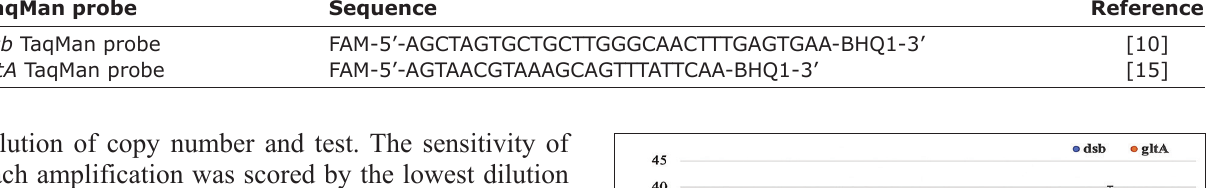
Table-2: TaqMan probe used for real-time polymerase chain reaction. TaqMan probe